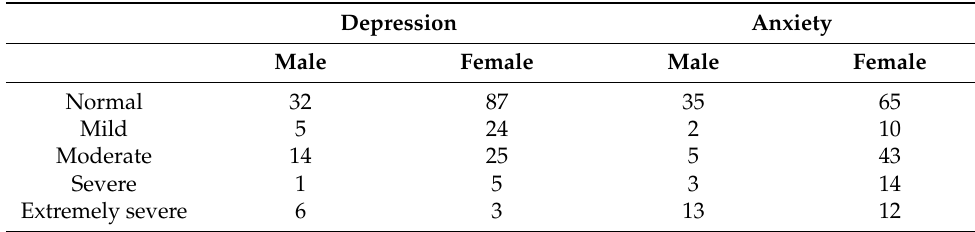
Table 2. Frequency of participants (by gender) in each of the depression and anxiety categories for the